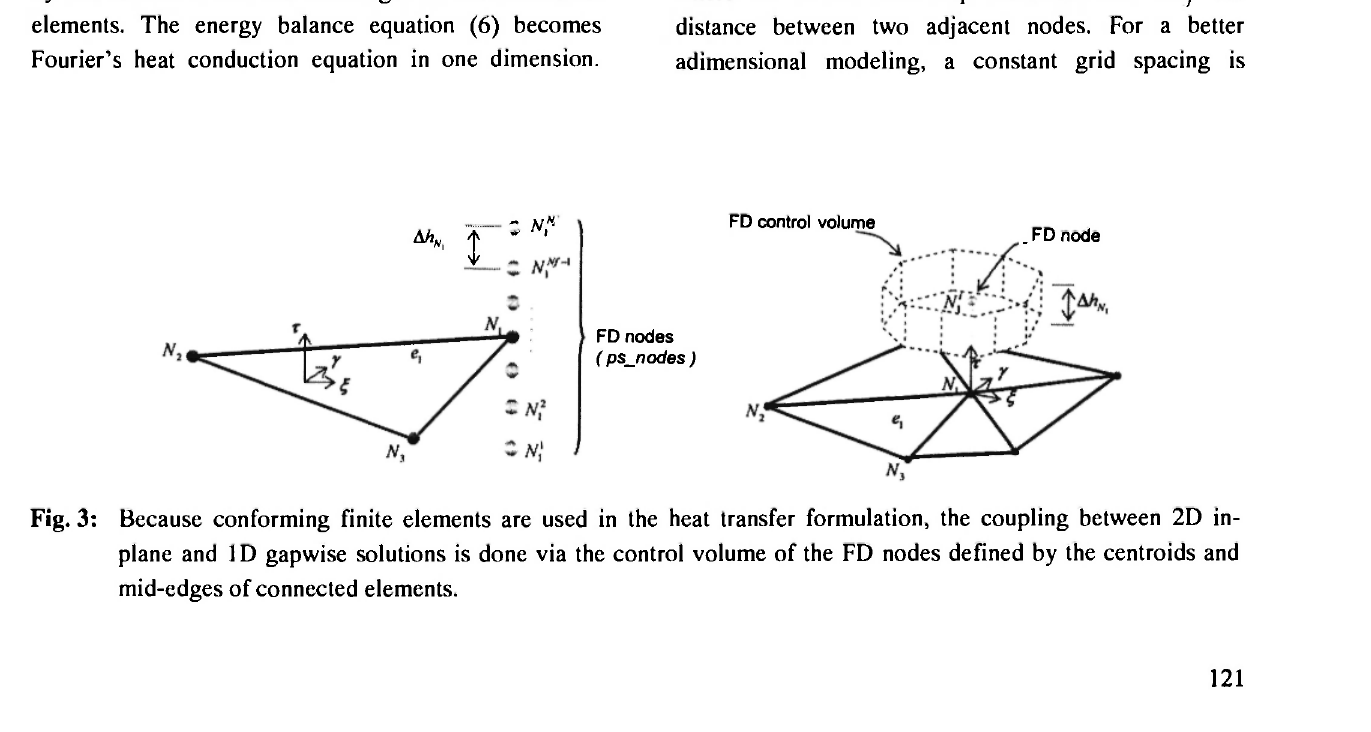
Figure 4. The discretization of the partial differential equation (18) is done with an implicit finite difference scheme. Crank-Nicolson formulation is used because it gives the smallest accumulated truncation error and an unconditionally stable linear system. In adimensional form, the energy balance for node j at position i and